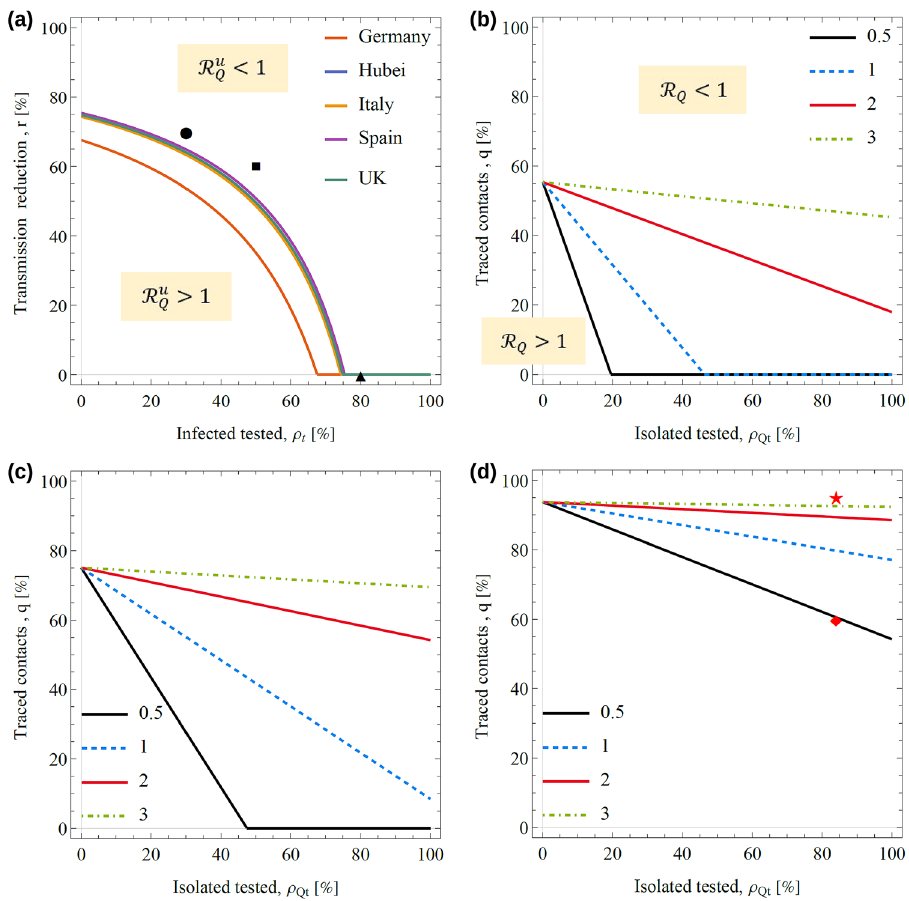
Figure 4. Suppression of the virus with physicals distance, enhanced testing, isolation and contact tracing. ( a ) Threshold lines for the reproduction number of untested cases as a function of the testing percentage ρ t and reduction of transmission, r . For a given country, R Q < 1 above the line and R Q > 1 below the line. The threshold lines for Italy and Hubei, Spain and UK are close to each other and hardly distinguishable in the plot. Taking the UK as an example, panels ( b – d ) show the threshold lines for suppression in terms of the isolation and contact tracing percentages of tested cases for different combinations of the testing percentage and reduction of transmission marked by the circle, square and triangle in panel ( a ). More explicitly, the parameters are (ρ t , r ) = ( 30%, 70% ) in panel ( b ), (ρ t , r ) = ( 50%, 60% ) in panel ( c ), and (ρ t , r ) = ( 80%, 0% ) in panel ( d ). For a given panel, different lines indicate the threshold for different values of the time to isolation, δ − 1 , as marked by the legend. In panel ( d ), the diamond and star correspond to situations with = ( 84%, 95% ) , respectively, which were used to simulate the effect of enhanced isolation and contact tracing on the daily deaths in the UK (see Sect. 4 in Additional file 3). All lines show estimates based on the median of the model